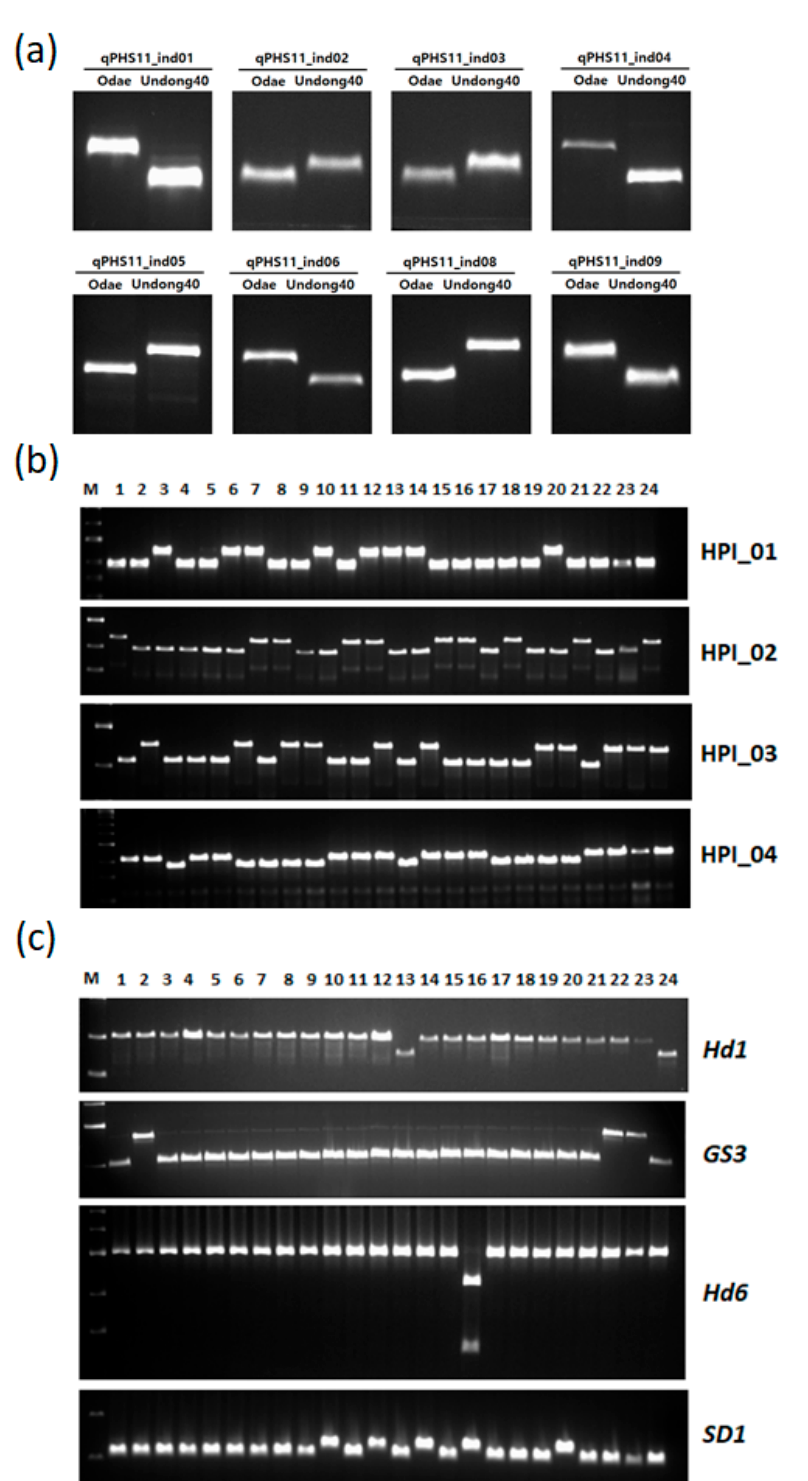
Figure 3. Development of markers based on sequence variation between 24 Korean japonica rice varieties. ( a ) Development of InDel markers in the qPHS11 region. ( b ) Development of markers based on highly polymorphic InDels. ( c ) Development of gene-based markers; gene names are given on the right-hand side of the photograph. M: standard size markers; 1 – 24 represent the varieties Cheongho, Dami, Dongan, Dongjin, Giho, Haechanmulgyeol, Hiami, Hwacheong, Hwayeong, Ilpum, Jinbu43, Jopyeong, Joun, Junam, Nampyeong, Odae, Saeilmi, Saenuri, Samgwang, Seogan, Seomyeong, Sindongjin, Sobi, and Unbong40, respectively.